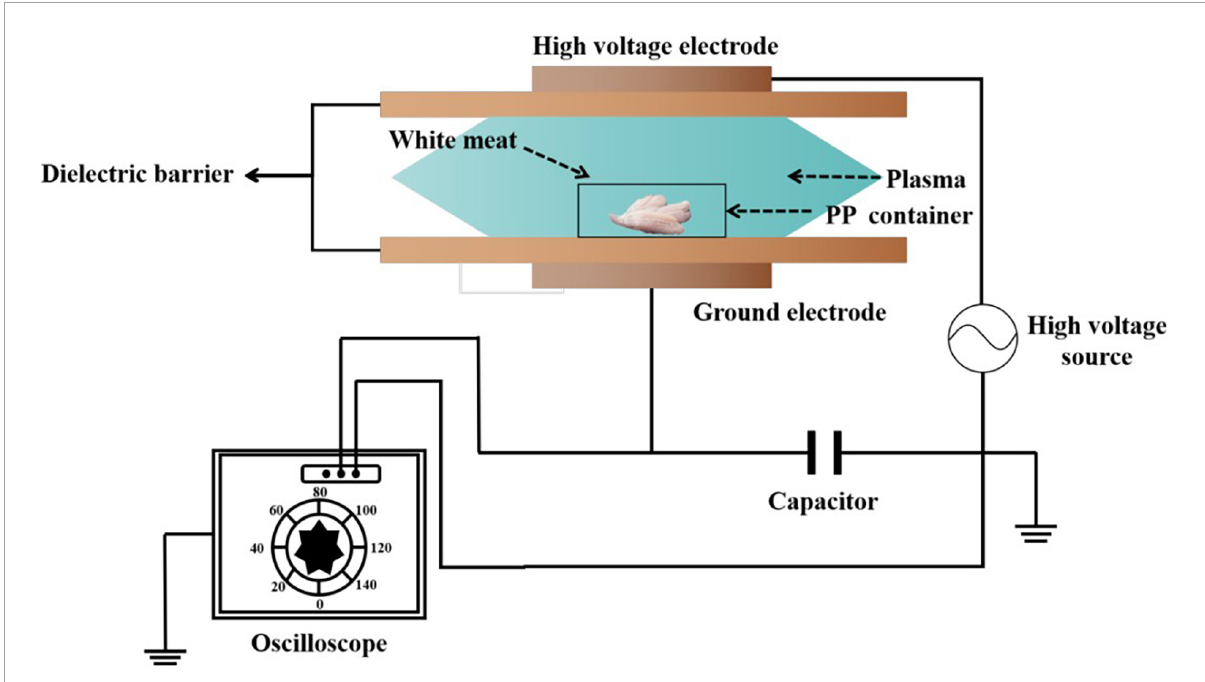
FIGURE1 Schematic diagram of dielectric barrier discharge